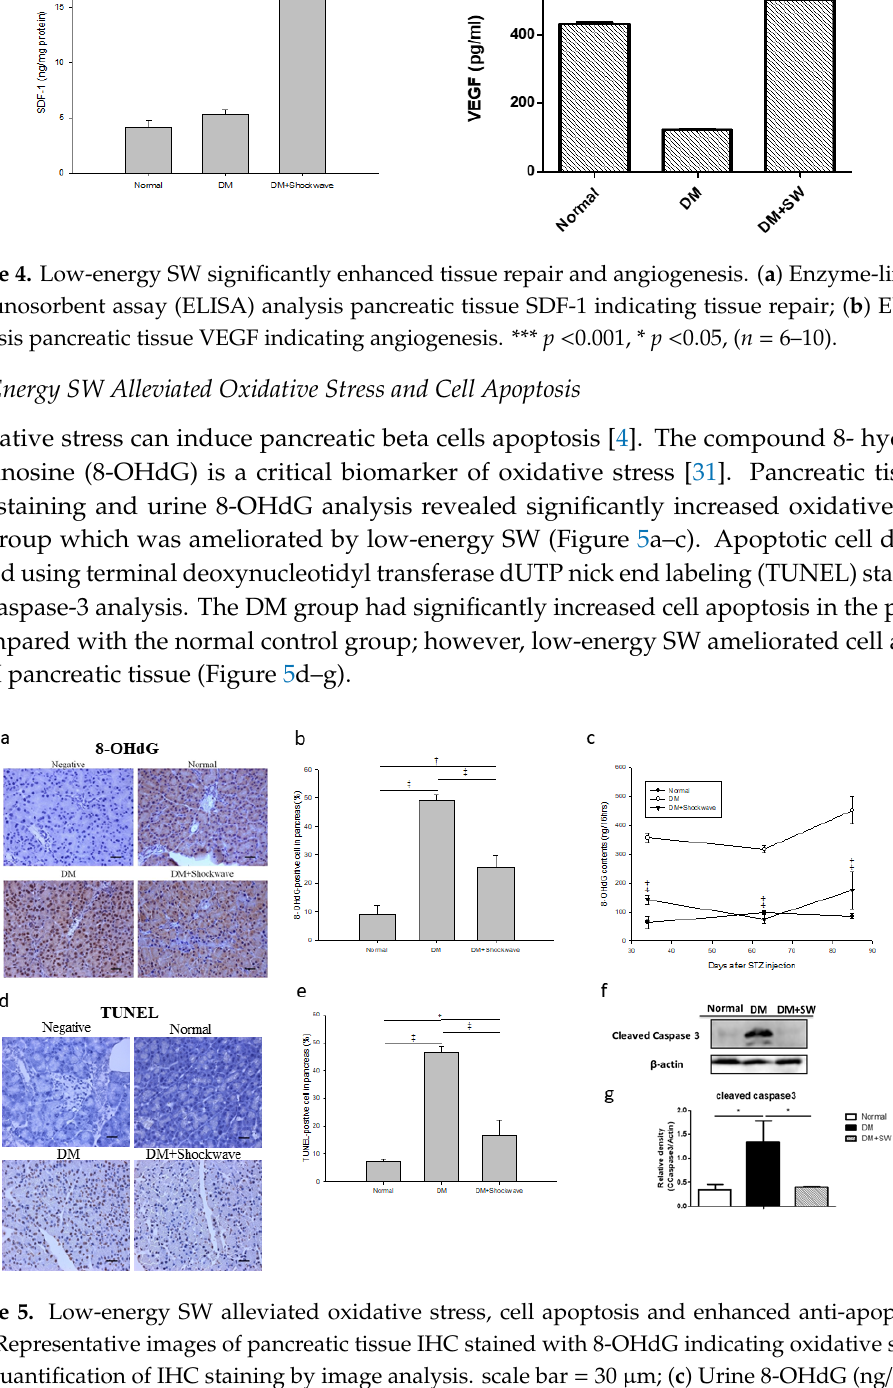
Figure 5. Low-energy SW alleviated oxidative stress, cell apoptosis and enhanced anti-apoptotic. ( a , b ) Representative images of pancreatic tissue IHC stained with 8-OHdG indicating oxidative stress and quantification of IHC staining by image analysis. scale bar = 30 µ m; ( c ) Urine 8-OHdG (ng / 16 h). ‡ p < 0.001 versus DM. Data are represented as mean ± SEM ( n = 12); ( d , e ) Representative images of pancreatic tissue IHC stained with TUNEL indicating cell apoptosis and quantification of IHC staining by image analysis. scale bar = 30 µ m; ( f , g ) Western blot analysis cleaved Caspase-3 indicating cell apoptosis in pancreatic tissue and quantification of Western blot by densitometric analysis. † p < 0.01, ‡ p < 0.001, * p < 0.05 ( n =